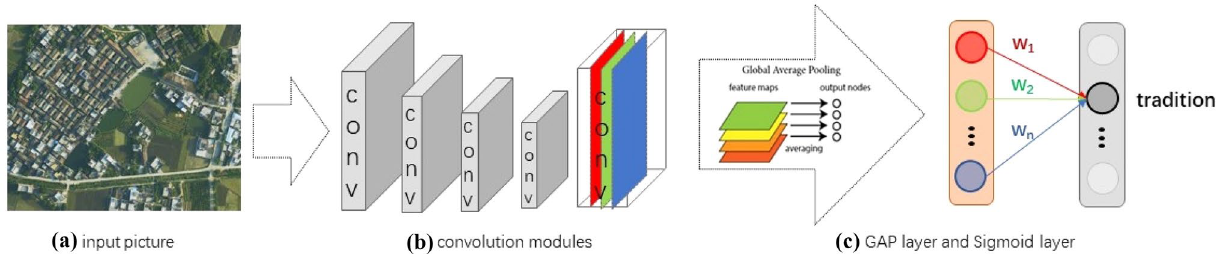
extracted. c After the global average pooling and Sigmoid layer, we get the final results